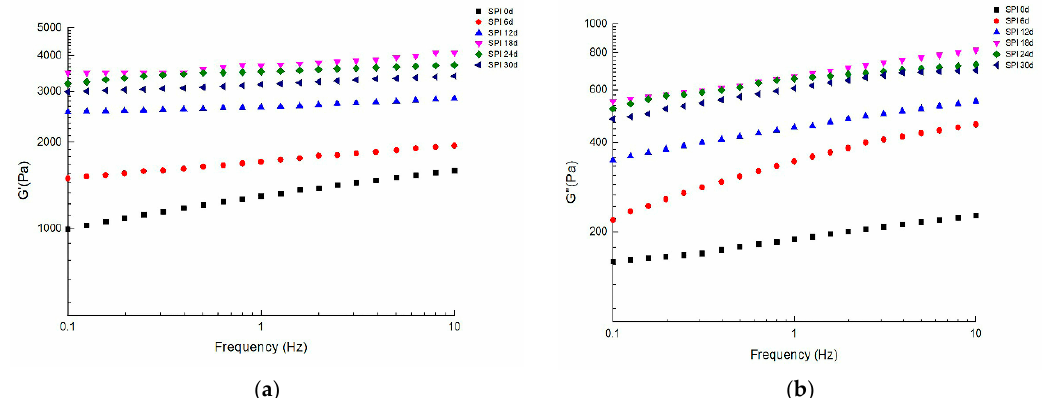
Figure 3. SDS–PAGE profile of SPI with different storage times.